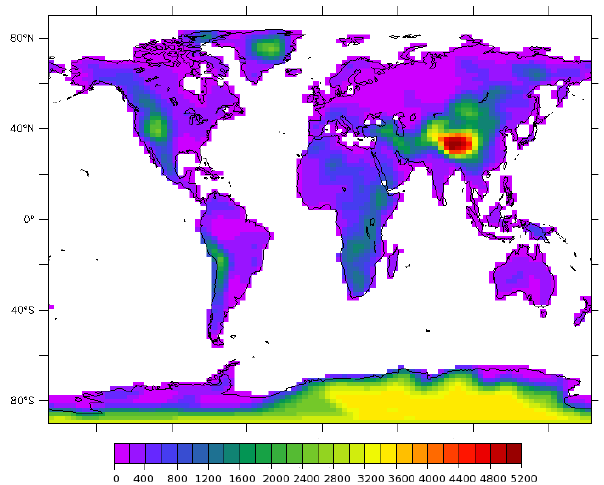
Fig. 2. Absolute implemented mid-Pliocene topography calculated via the anomaly method, expressed in